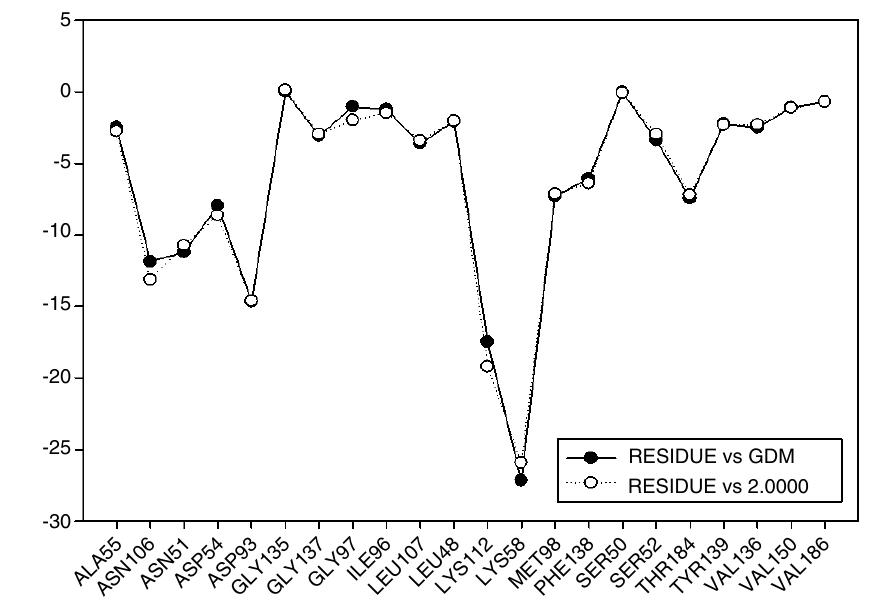
Figure 16. Comparison of the interaction energies of geldanamycin and analog